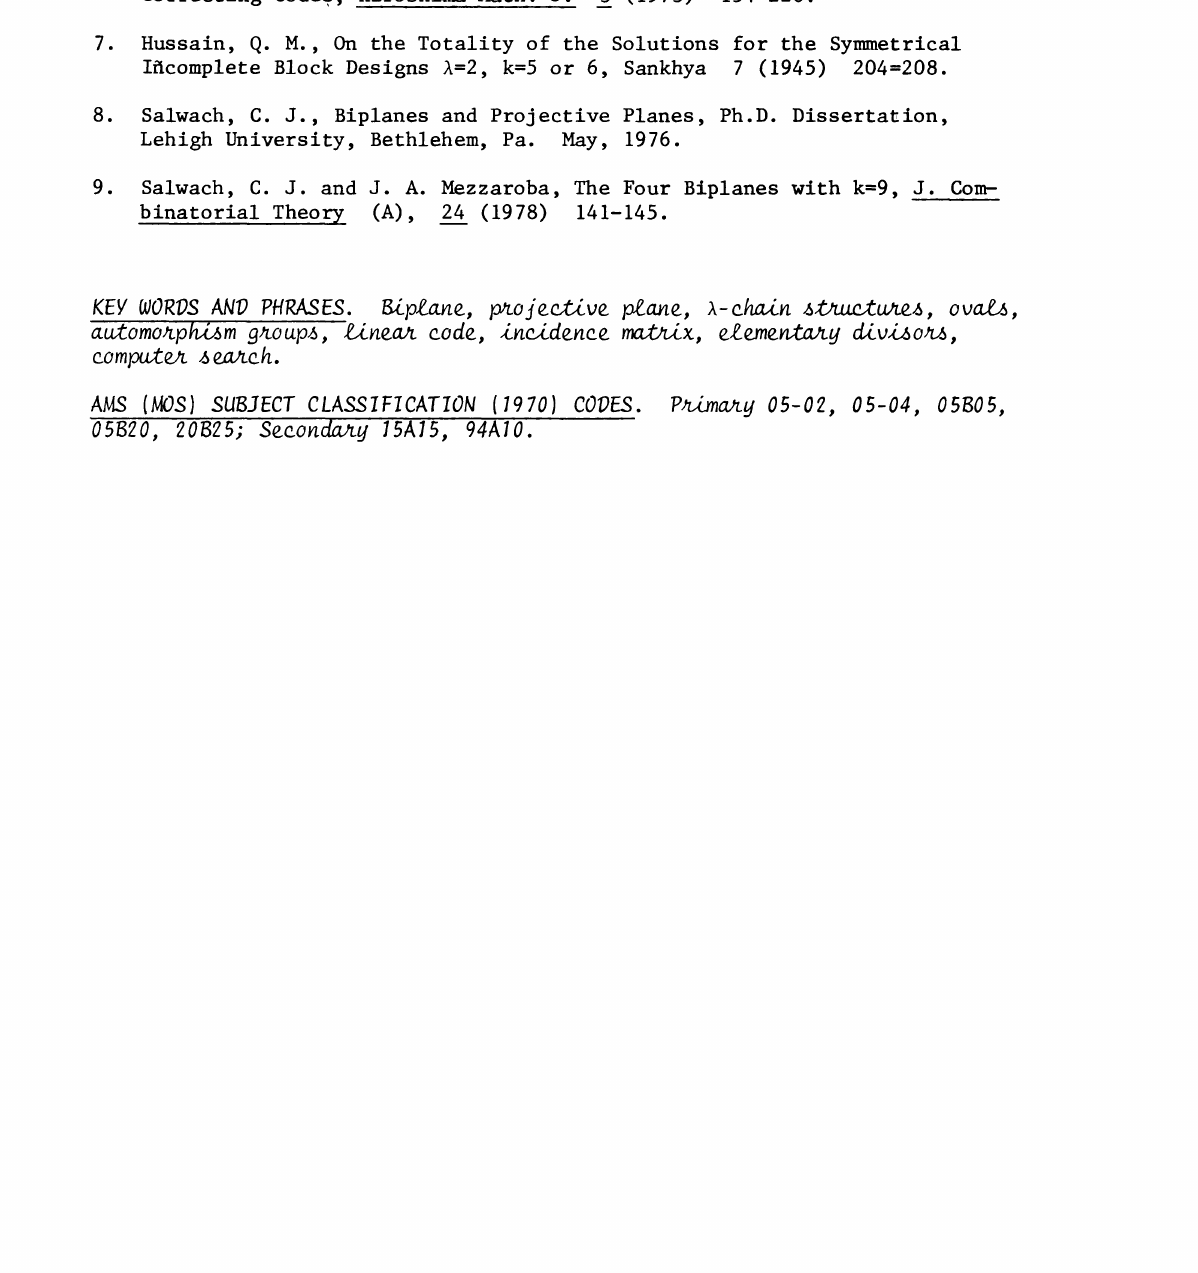
Biplane, projective plane, l-chain struures, ovals, automorphsm groups, linear code, incidence matrix, elementary divisors, compeer search. AMS (MOS) SUBJECT CLASSIFICATION (1970)